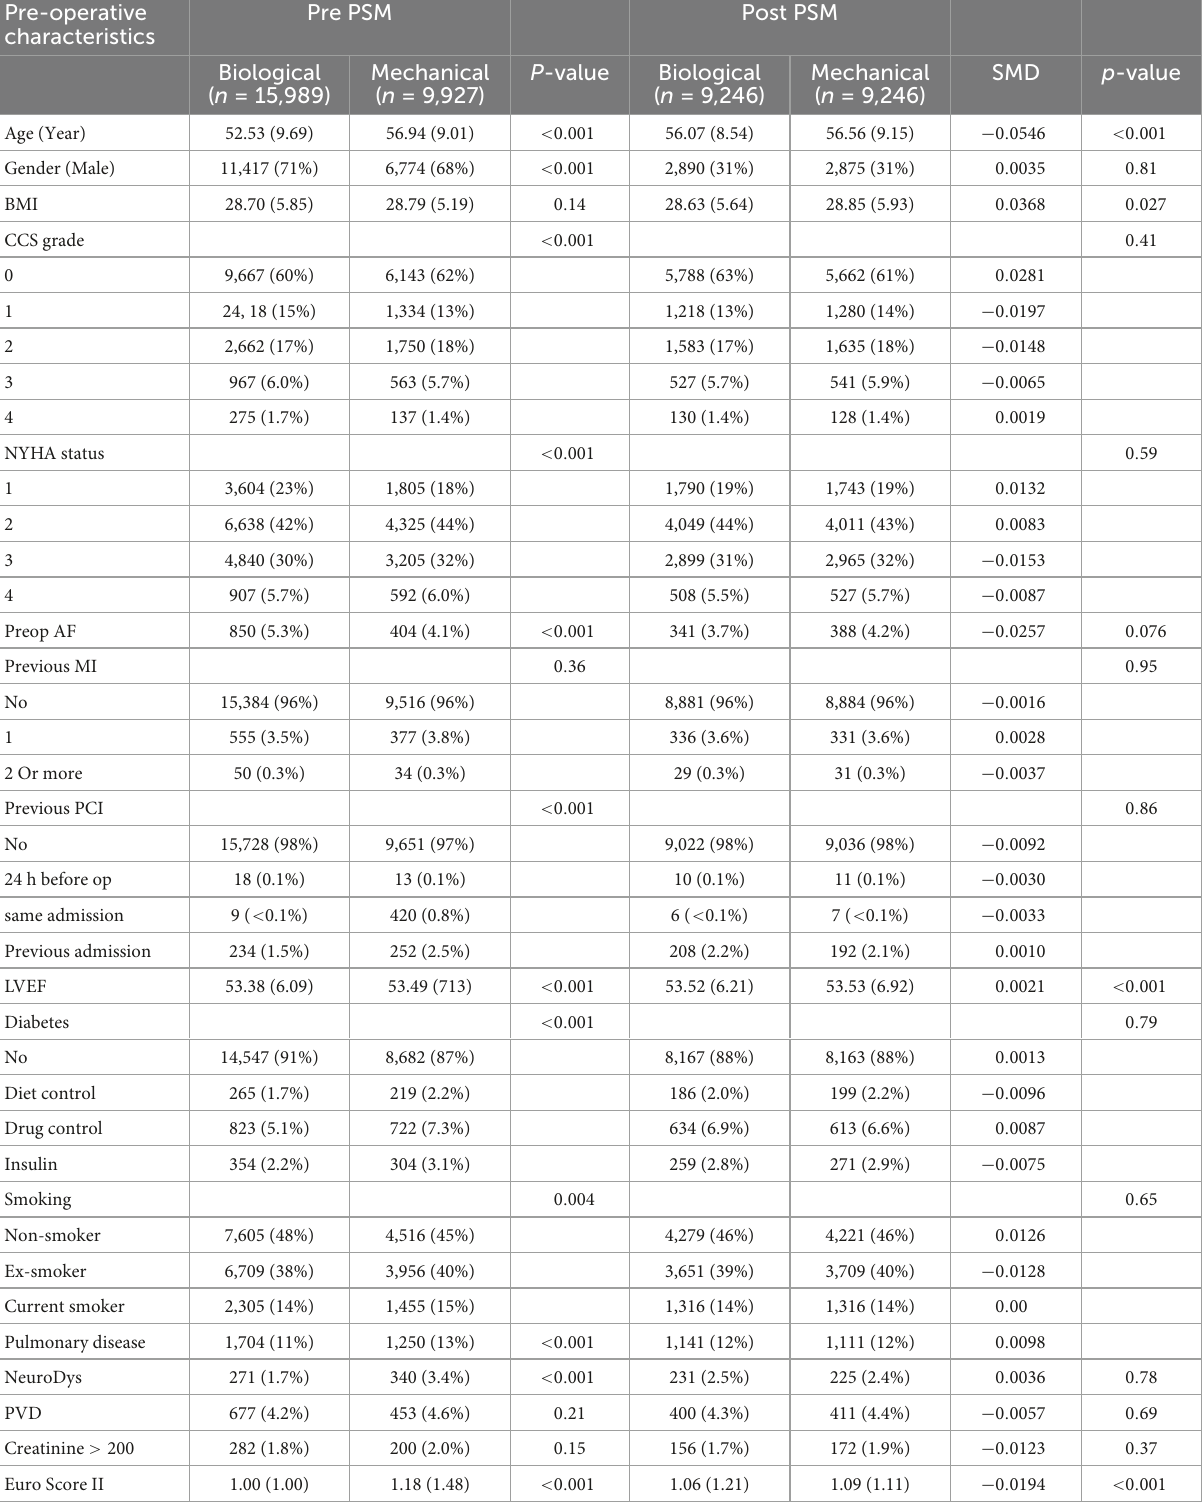
TABLE 3 Pre-operative characteristics of the biological and mechanical prostheses in patients < 65 years old before and after propensity score matching. Pre-operative